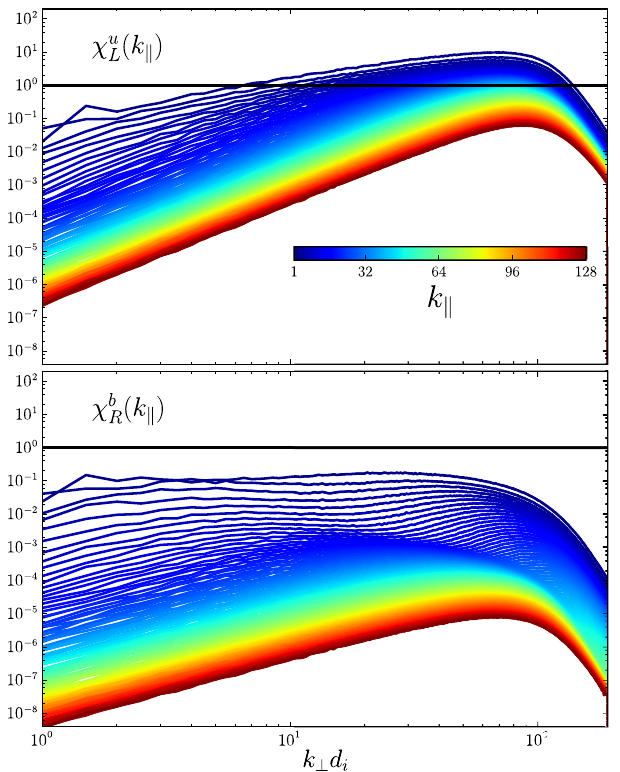
FIG. 1. Transverse wave number dependence of the time ratios χ u χ b L (top panel) and R (bottom panel) for different values of t ∼ 90 ω ci (run I). The horizontal line marks the demarcation between weak (below) and strong (above) wave